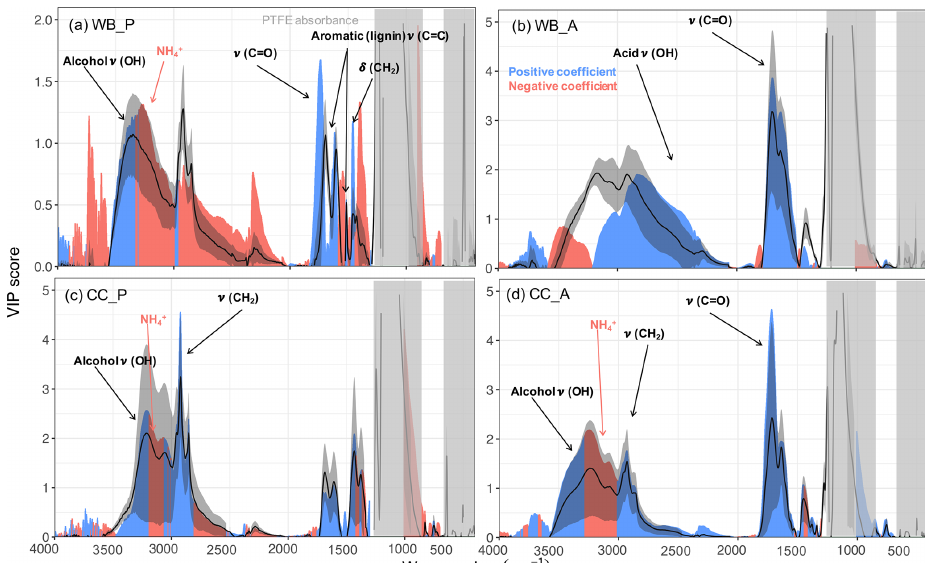
Figure 2. VIP scores of the MIR absorbances regressed against the AMS OM concentration (averaged over the filter sampling periods) for primary wood burning, WB_P (a) , aged wood burning, WB_A (b) , primary coal combustion, CC_P (c) , and aged coal combustion aerosols, CC_A (d) . Blue and red regions correspond to wavenumbers with positive and negative regression coefficients in the PLSR models, respectively. Solid curves show the average spectrum ( ± 1 standard deviation shown by the shaded bands) for each category. Important functional groups are indicated for each category. The PTFE interference regions are masked by gray